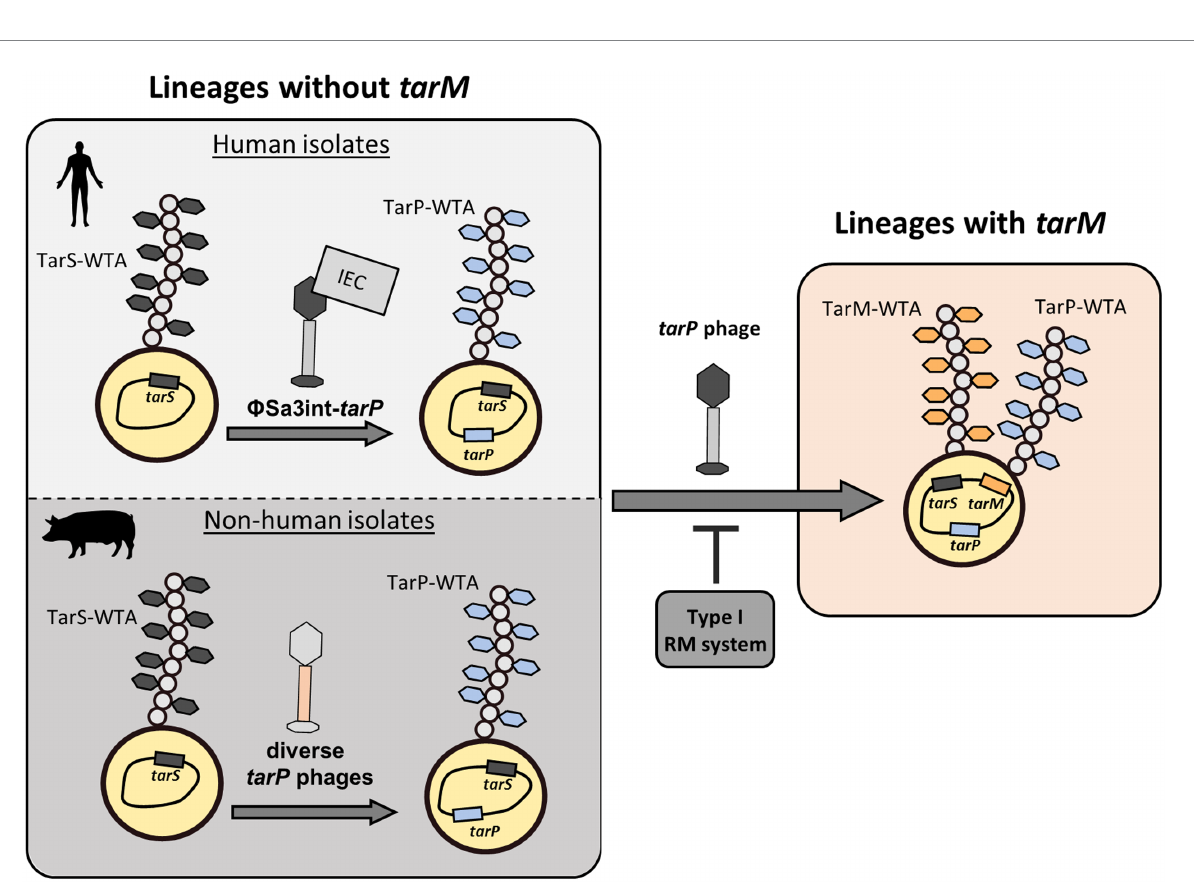
FIGURE 6 Summary of distribution of tar phages. tarP phages are prolific in clonal lineages of S. aureus that are devoid of the genome-encoded, alternative glycosyltransferase tarM . Here, TarP-glycosylation appears to be dominant over TarS-glycosylation. Furthermore, the make-up of tarP phages shows a stark discrepancy between Sa3int-phages with presumed IEC in human isolates and diverse non-Sa3int-phages in non-human isolates. Upon integration of tarP phages, lysogens express a dominant tarP -WTA. Transfer of tarP phages into tarM -encoding clonal lineages such as (CC1, CC8, and CC30) is mainly suppressed by type I RM systems. However rare bypassing of the host restriction barrier leads to expression of a TarM/ TarP-hybrid-WTA.